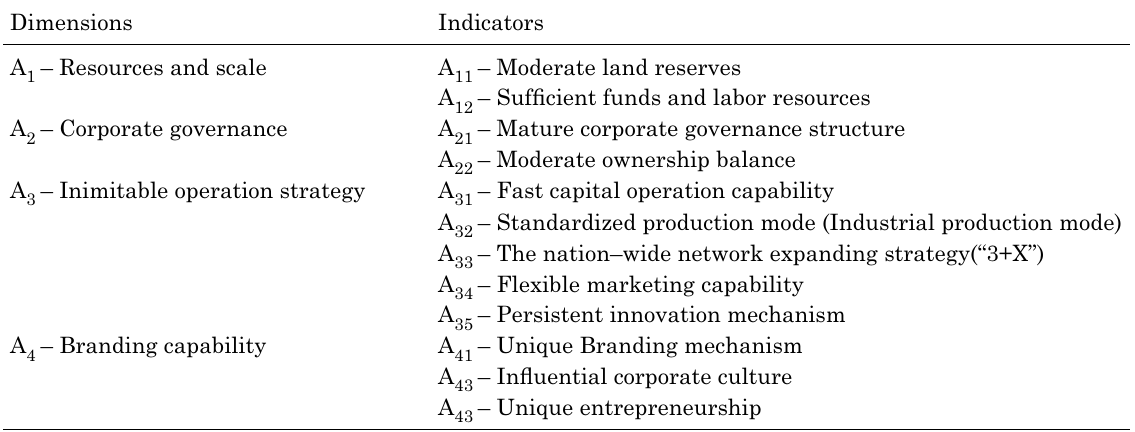
Table 3. The Key competitiveness indicators for China Vanke